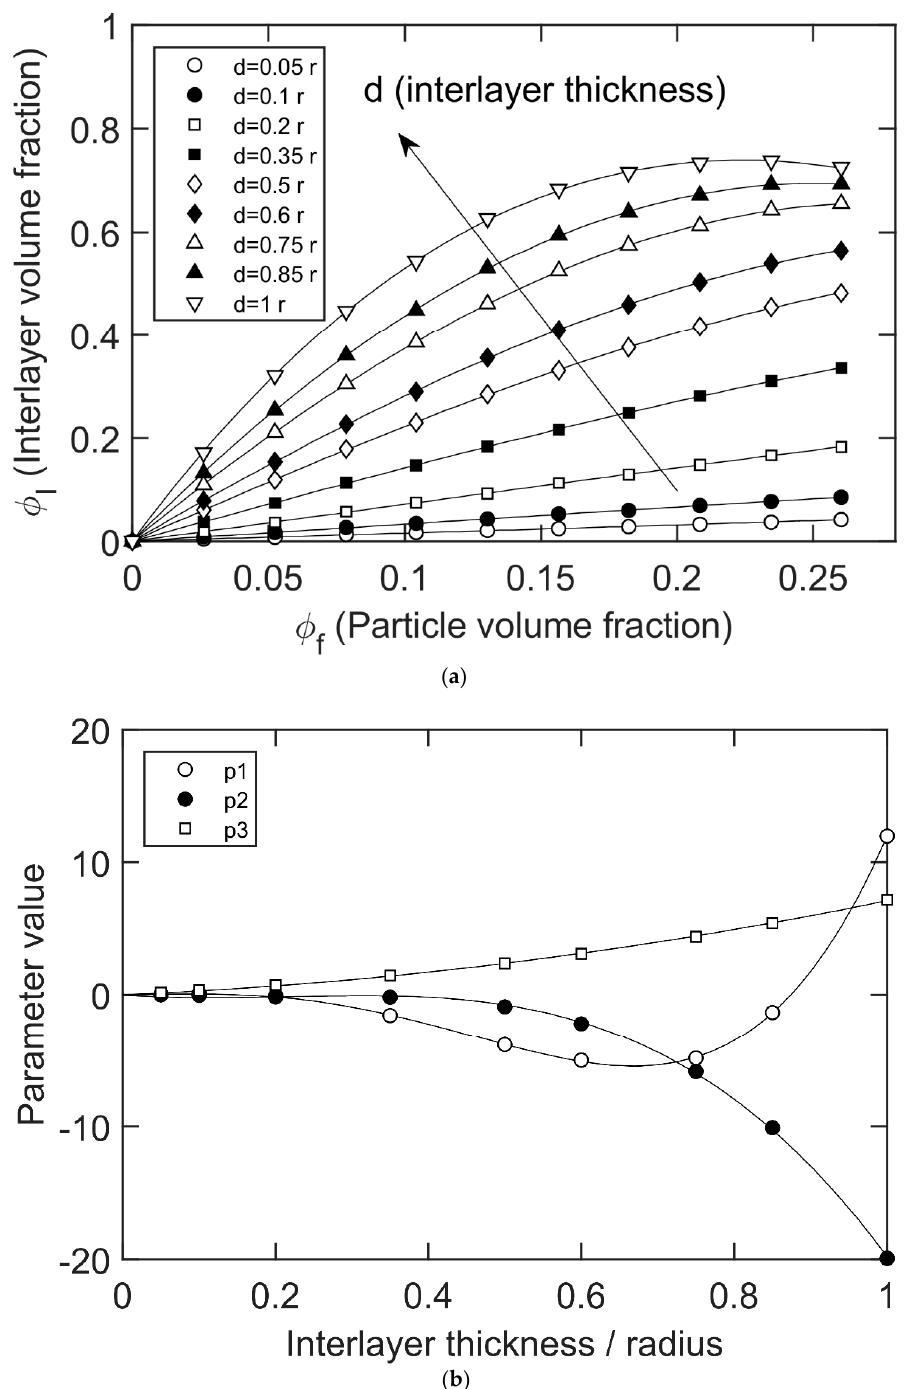
Figure 6. ( a ) interlayer fraction ϕ I as a function of filler fraction ϕ f and interlayer thickness d. The solid lines are best fits with the polynomial ϕ I = p 1 ϕ f 3 + p 2 ϕ f 2 + p 3 ϕ f . ( b ) fitting parameters p1–p3 (markers) and fourth order polynomial fits (lines).